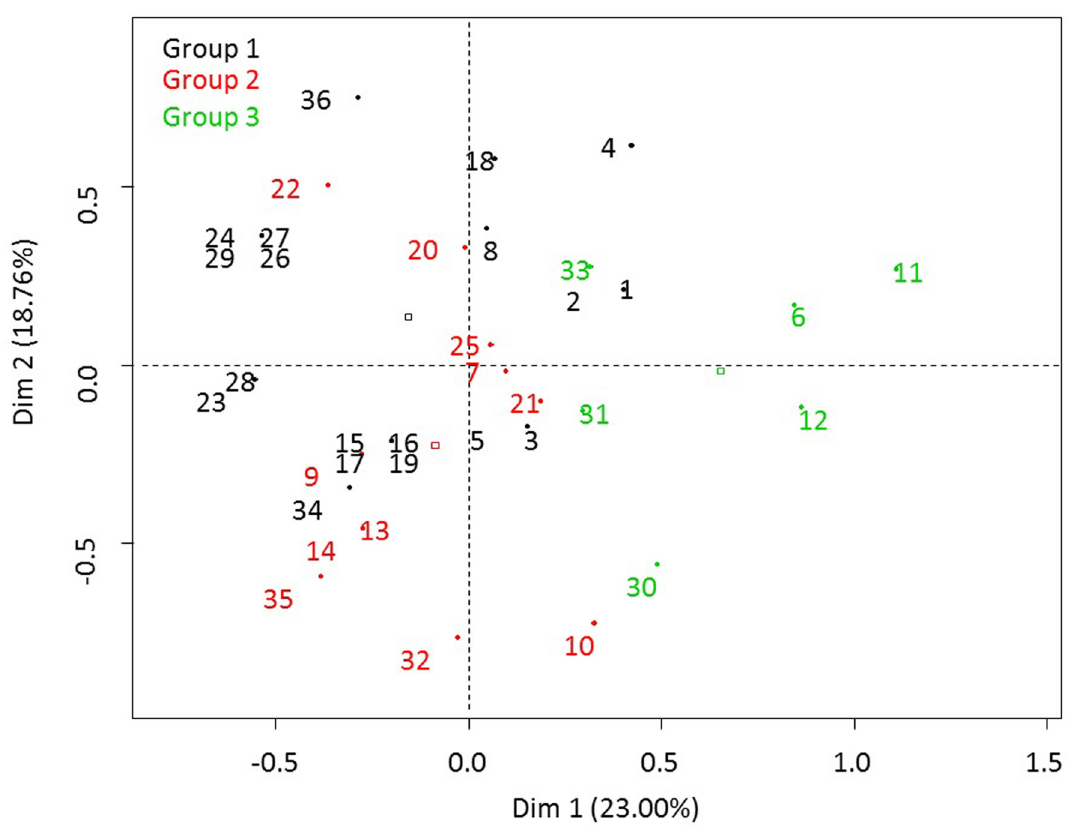
Fig 3. Ascending hierarchical classification of individuals (using the first 5 dimensions of multiple component analysis performed using data for 36 females with complete data) did not reveal any significant groups.